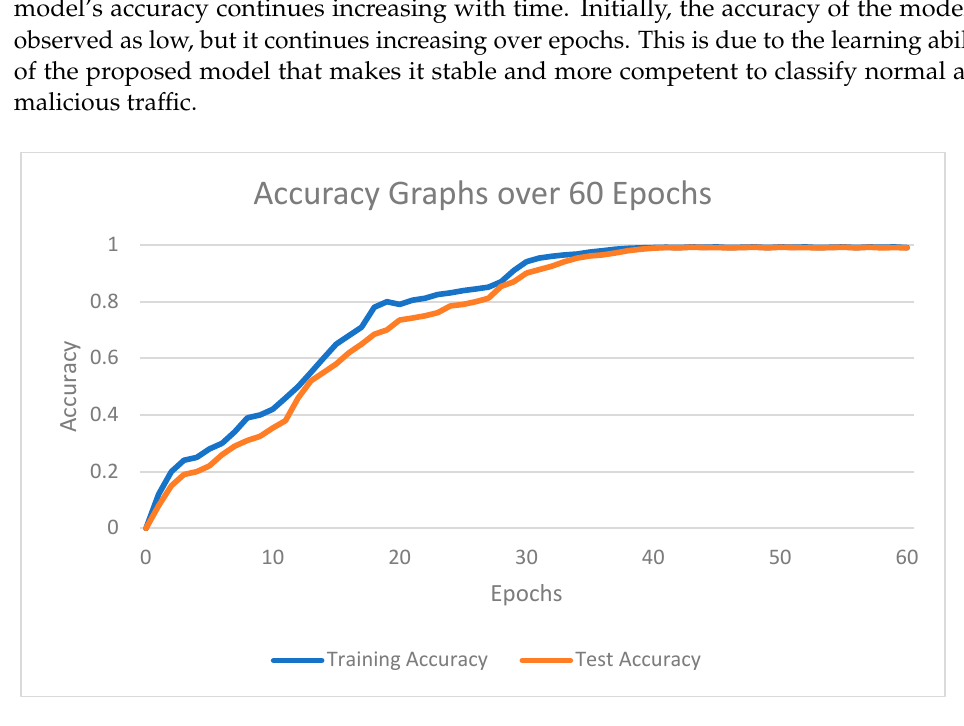
Figure 2. Accuracy of proposed deep learning model with respect to epochs.